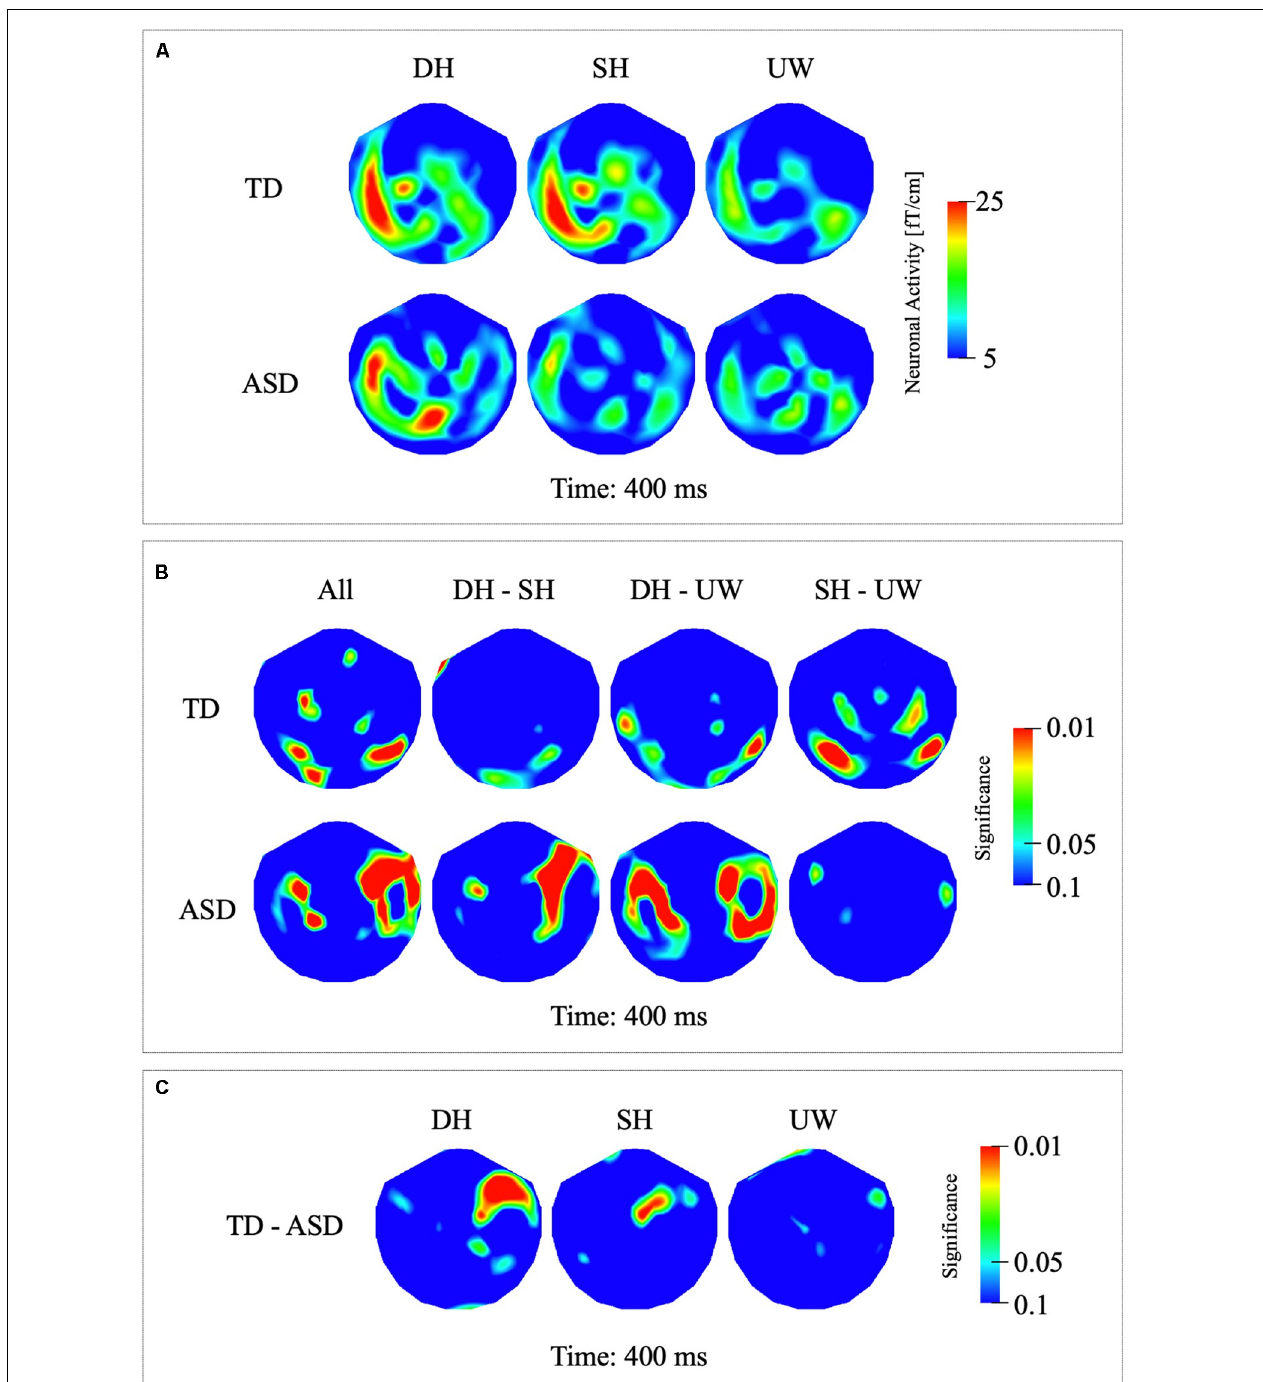
FIGURE 4 | (A) First row: Local RMS-maps for the TD group’s responses to final words (dominant homonym, subordinate homonym, and unambiguous word) at 400 ms. Second row: Local RMS-maps for the ASD group’s responses to final words (dominant homonym, subordinate homonym, and unambiguous word) at 400 ms. (B) First row: TD group’s Friedman analysis result for dominant homonym, subordinate homonym, and unambiguous word at 400 ms. Wilcoxon pairwise analysis result of dominant homonym and subordinate homonym, dominant homonym and unambiguous word, and subordinate homonym and unambiguous word at 400 ms. Second row: ASD group’s Friedman analysis result for dominant homonym, subordinate homonym, and unambiguous word at 400 ms. Wilcoxon pairwise analysis result of dominant homonym and subordinate homonym, dominant homonym and unambiguous word, and subordinate homonym and unambiguous word at 400 ms. (C) Mann–Whitney U analysis result for TD vs. ASD groups’ responses to final words (dominant homonym, subordinate homonym, and unambiguous word) at 400 ms. For the presentation of data, the detectors have been projected into two dimensions (right ear on the right, front at the top).